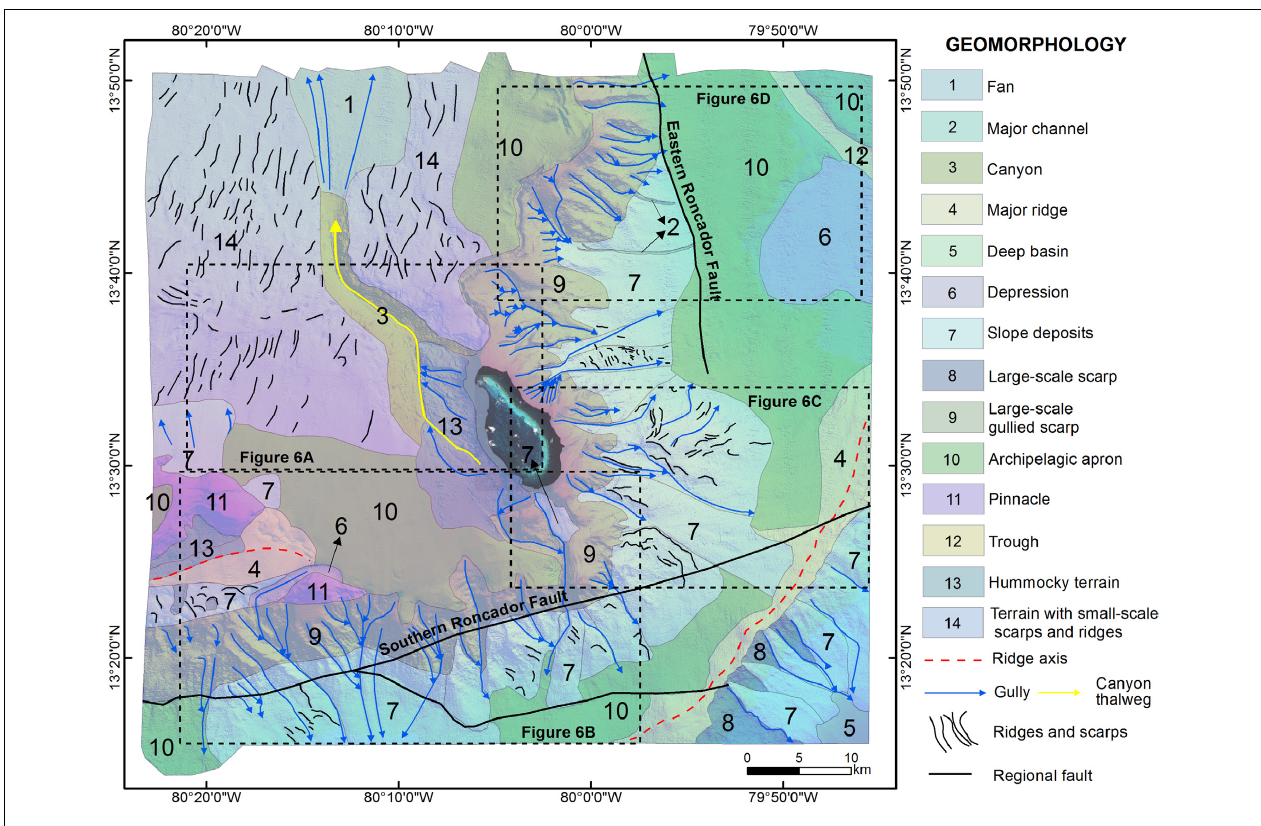
FIGURE 4 | Submarine geomorphological map of Roncador Bank and adjacent areas, where the main geomorphic features are shown. The satellite image covers the reef constructions shallower than –40 m and the permanently emerged areas (cays). The boxes indicate the location of Figure 6 . See text for detailed description.